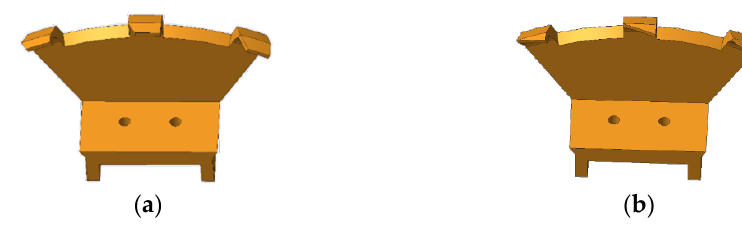
Figure 7. Scraper shapes: ( a ) flat scraper and ( b ) sharp scraper.